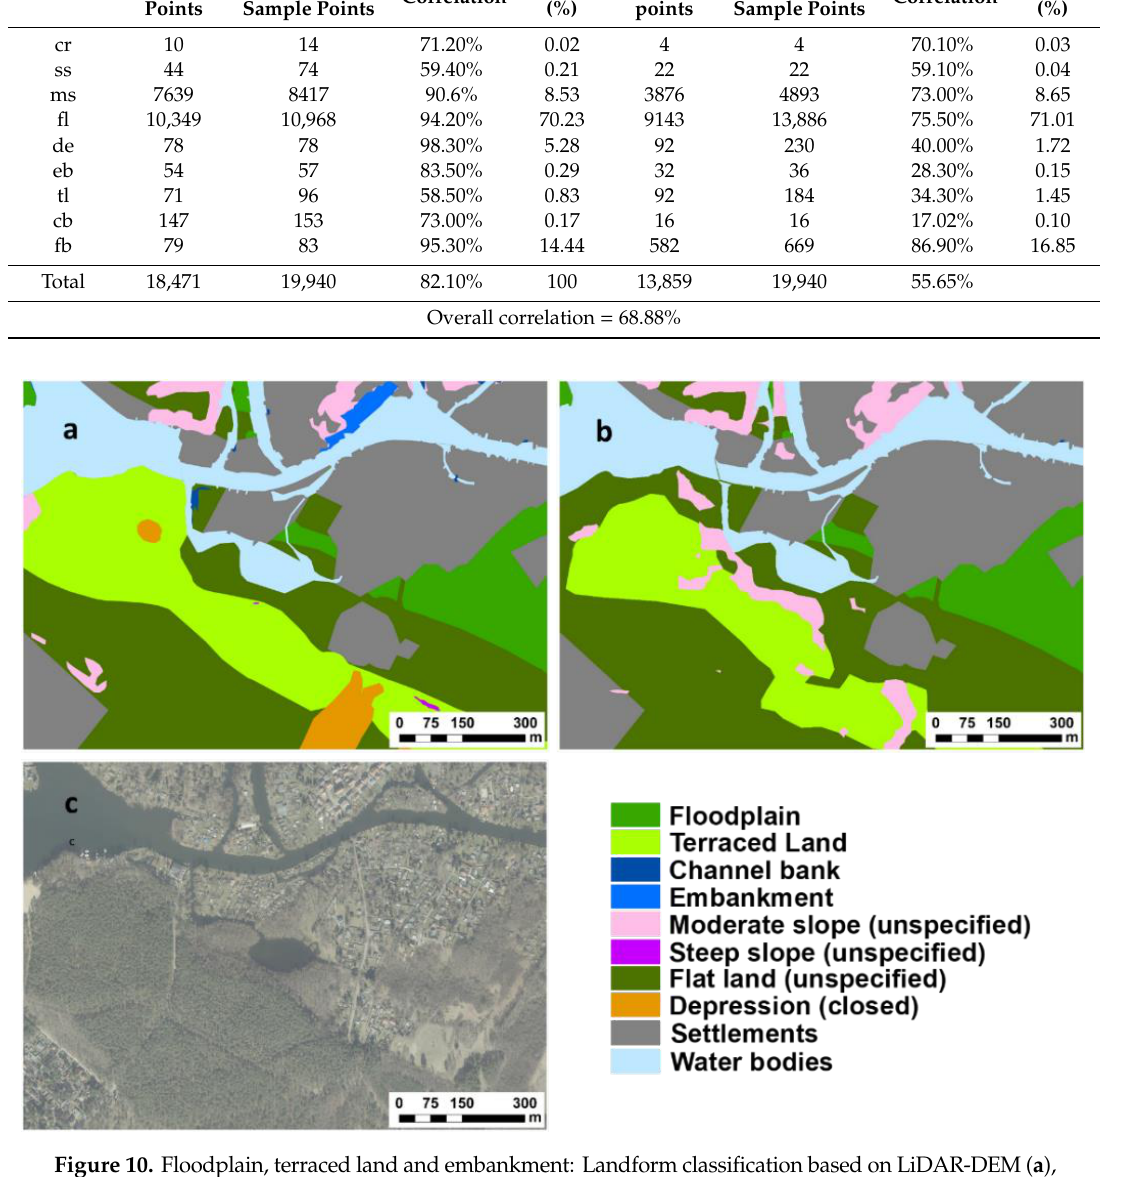
Figure 10. Floodplain, terraced land and embankment: Landform classification based on LiDAR-DEM ( a ), landform classification based on ASTER-DEM ( b ) and orthophoto (0.2 m) ( c ).